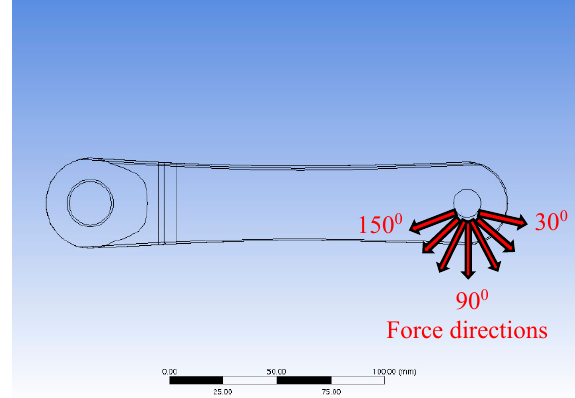
Figure 3. Multiple forces with various angles. Appl. Sci. 2019 , 9 , x FOR PEER REVIEW